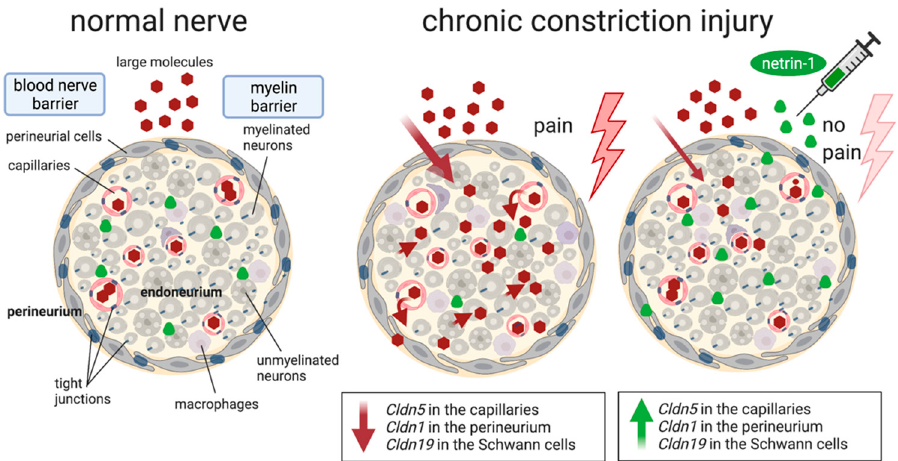
Figure 6. Barrier breakdown in chronic constriction injury and its rescue by the multitarget barrier sealer netrin-1. Nerve ligation results in opening of the myelin barrier and the BNB with correspond- ing loss of tight junction proteins. Netrin-1 protein remains low. Replacing netrin-1 by exogenous application reverses these changes (especially of the myelin and the capillary barrier) and relieves neuropathic pain. Created with biorender.